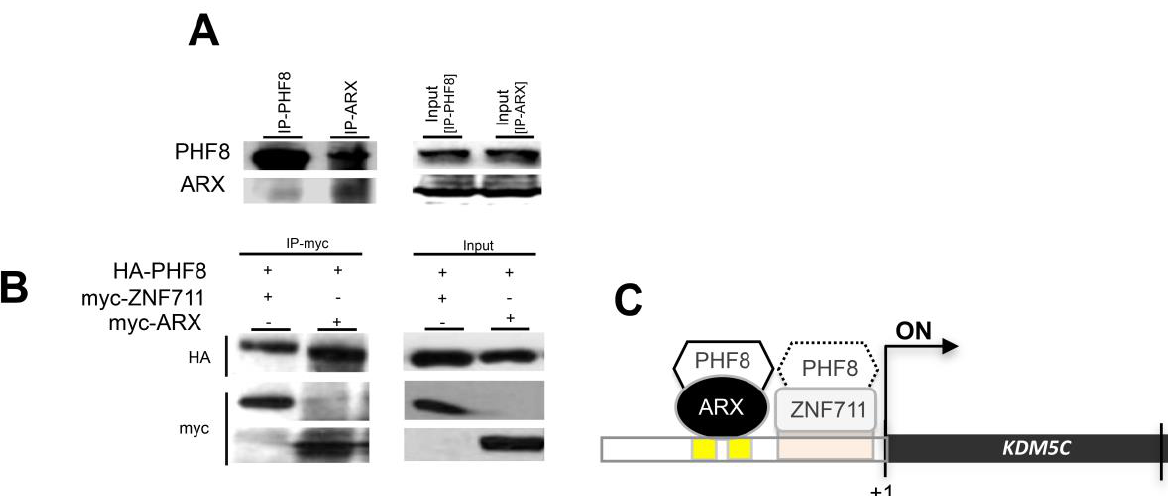
Figure 5. Co-immunoprecipitation of PHF8 and ARX in SH-SY5Y cells. Co-IP of endogenous PHF8 and ARX and vice versa. Cell lysates were subjected to immunoprecipitation with anti-PHF8 or anti-ARX antibodies. The presence of PHF8 and ARX in the cell extracts prior to immunoprecipitation was checked using anti-PHF8 and anti-ARX antibodies (Input) ( A ). Cells were transfected with a pCMV vector to express HA tagged-PHF8 (120 kDa), or Myc tagged-ARX (75 kDa), or Myc tagged-ZNF711 (100 kDa) ( B ). The cell lysates were subjected to immunoprecipitation with anti-HA or anti-Myc- antibodies. The presence of PHF8-HA, ZNF711-Myc, and ARX-Myc in cell extracts prior to immunoprecipitation was checked using anti-HA and anti-Myc antibodies (Input). Regulatory interactions with activating effects on KDM5C transcription are shown in the carton ( C